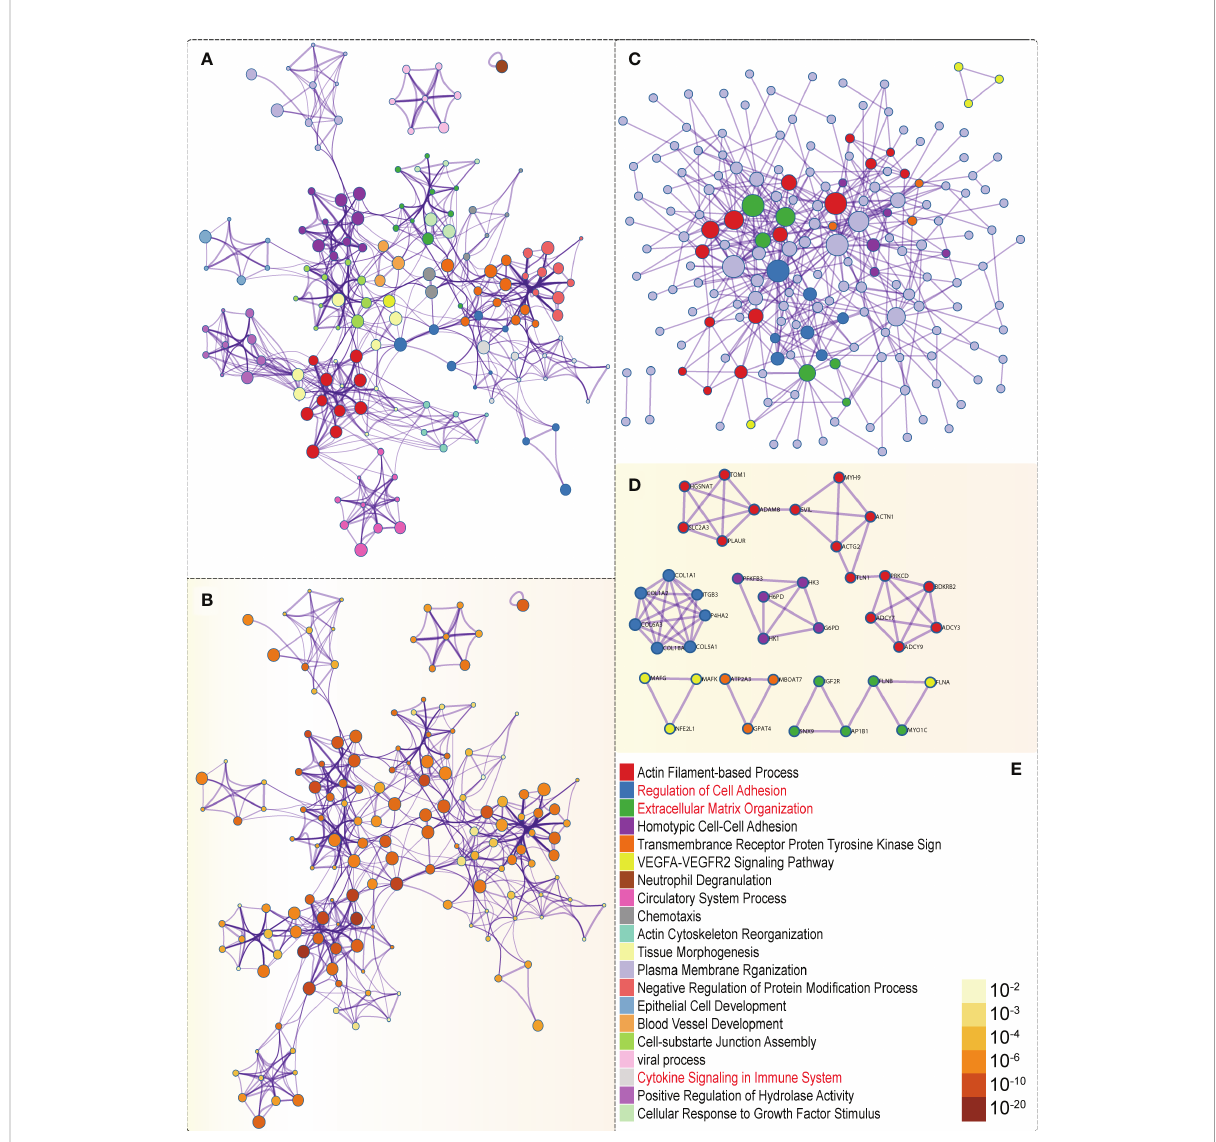
FIGURE 9 PPI network and mRNA enrichment terms negatively correlated with ASB3. (A) Colored by cluster ID. (B) Colored by P-value. (C) PPI network. (D) MCODE components. (E) Legend of Figure